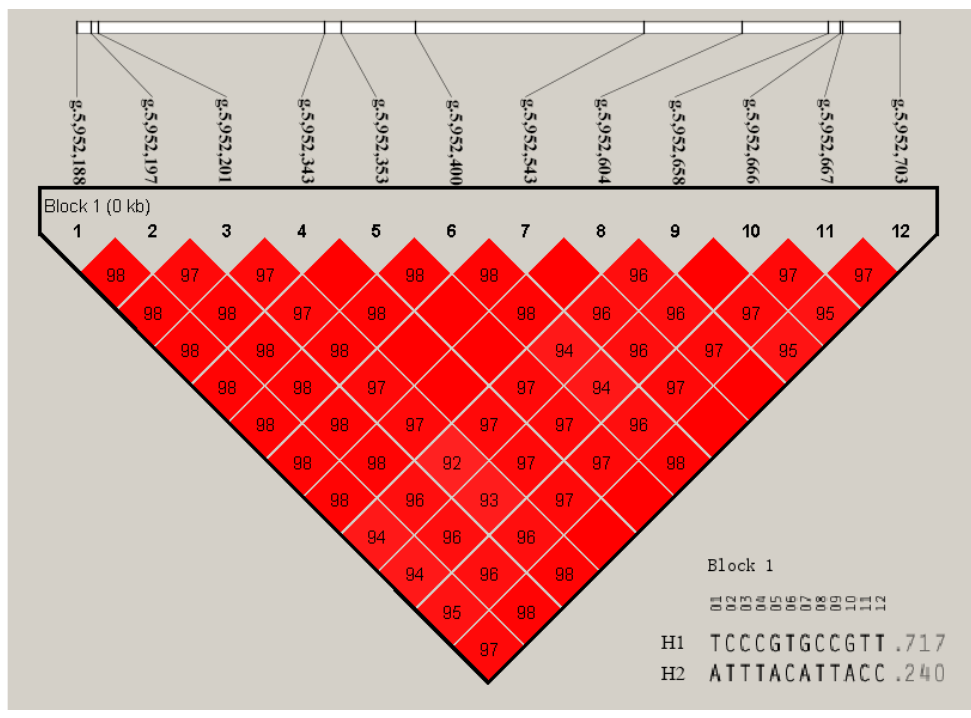
Figure 5. The linkage disequilibrium analysis for the RXRA SNPs. Table 4. Association analysis between haplotype and feed efficiency traits.